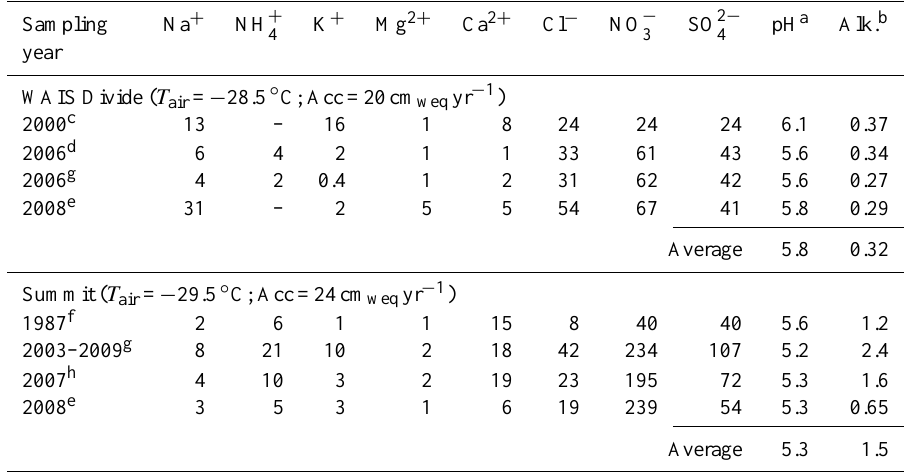
Table 2. Concentrations of major ions (in ppbw) measured in surface snow at WAIS Divide and Summit, Greenland, and the respective estimated pH and alkalinity.